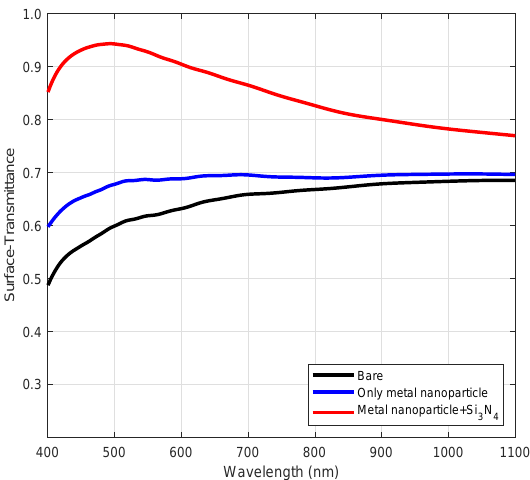
Figure 5. Front surface transmission of bare Si solar cell, cell with MNP directly placed over Si and cell with MNP+ Si 3 N 4